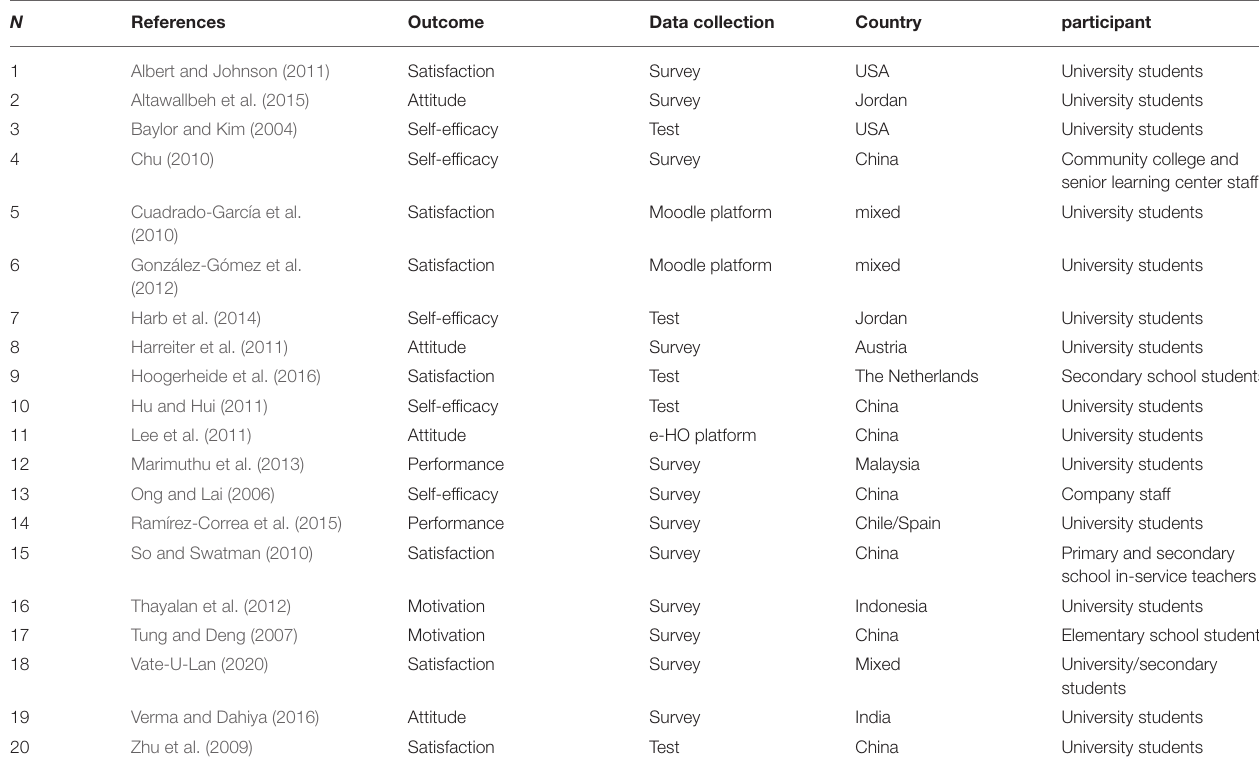
TABLE 1 | Characteristics of included